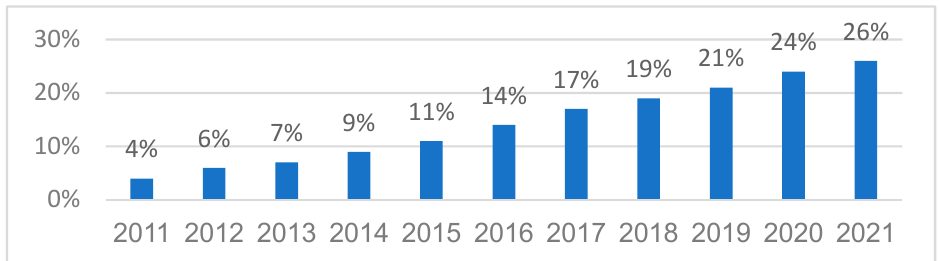
Figure 1. The proportion of installed capacity of new energy in China over the years.